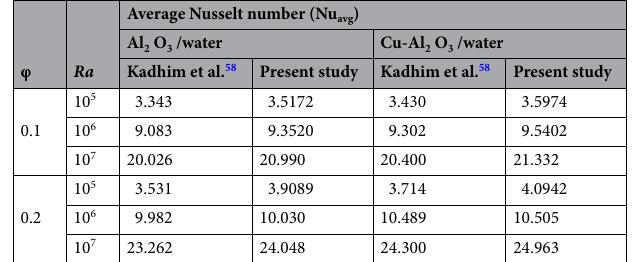
Table 3. Comparison of the average Nusselt number with Kadhim et al. 58 for Al 2 O 3 /water nanofluid and Cu-Al 2 O 3 /water hybrid nanofluid at Da = 10 –3 , N =